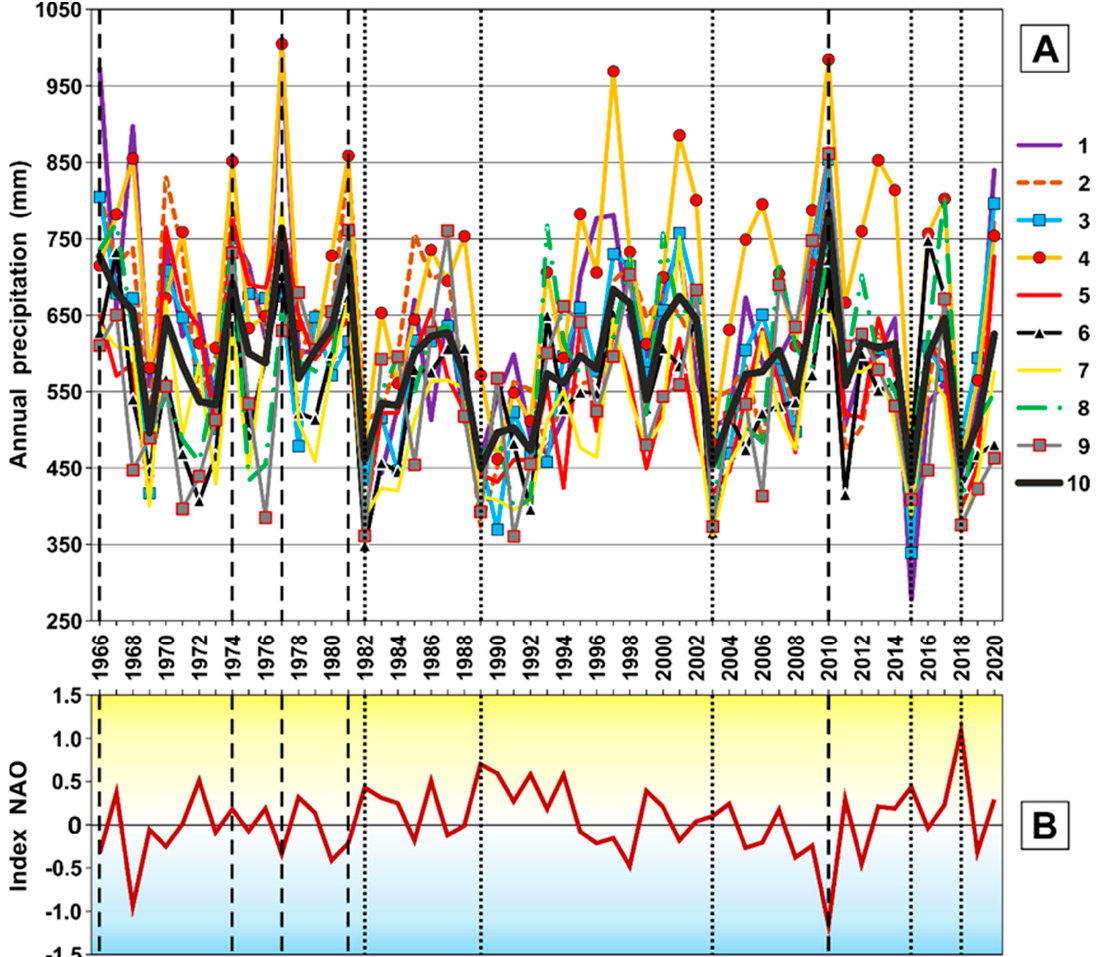
Figure 5. ( A ) Annual precipitation totals at 9 precipitation-gauging stations from the upper and middle Odra River catchment and average annual precipitation for these stations. ( B ) Annual average of the NAO index. Dashed lines indicate 5 years with the highest average precipitation at the nine stations and dotted lines 5 years with the lowest average precipitation. Precipitation-gauging stations: 1-Racibórz; 2-Opole; 3-K ł odzko; 4-Jelenia Góra; 5-Wroc ł aw; 6-Leszno; 7-Legnica; 8-Zielona Góra; 9-S ł ubice; 10-average value of annual precipitation at the nine stations. Table 1. Results from linear regression analysis for the relationships between annual precipitation totals recorded at 9 stations from the upper and middle parts of the Odra River catchment as well as catchment-average annual precipitation, and calendar years. p -values < 0.05 are indicated in bold. Goodness of Fit Significance Station Slope of Regression (B) (R 2 ) ( p Value) Racibórz − 2.277 0.07 0.04 Opole − 2.551 0.12 0.01 K ł odzko